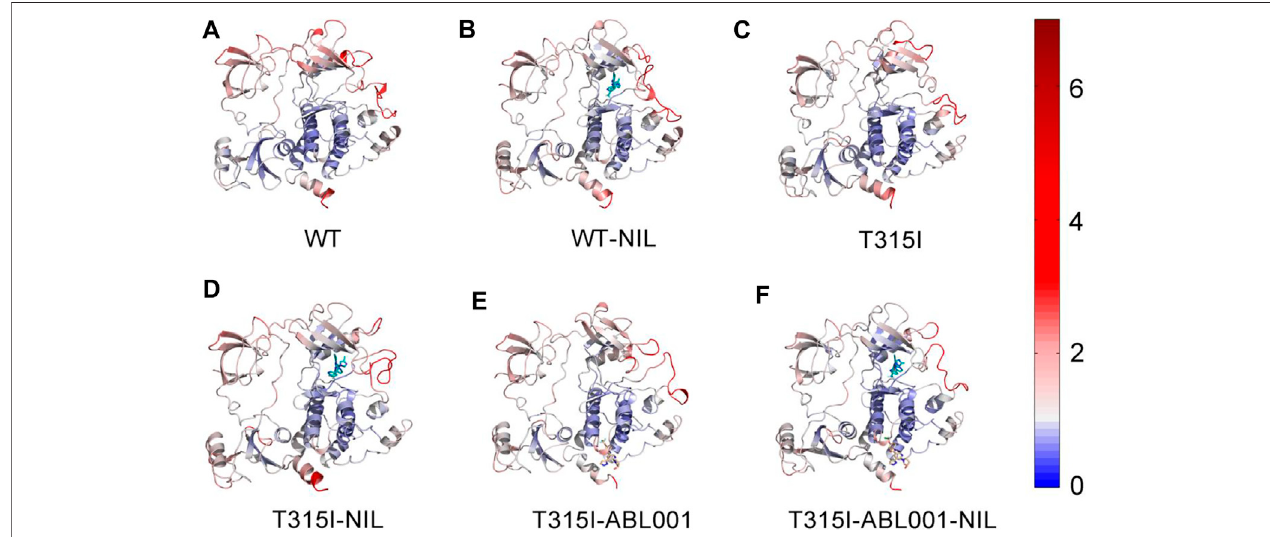
FIGURE 3 | Comparison of principal mode of motion along PC1 in WT (A) , WT-NIL (B) , T315I (C) , T315I-NIL (D) , T315I-ABL001 (E) and T315I-ABL001-NIL (F) systems. Red arrows depict the directions of protein motions, while the length of the arrows represents the magnitude of the movements.